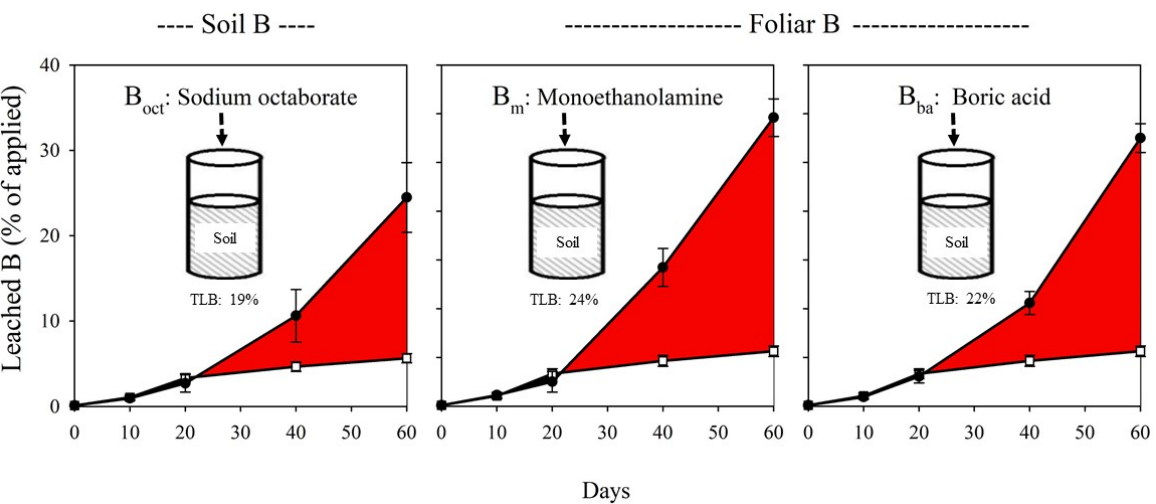
Figure 7. Leached B (% of applied) and total leached B (TLB; %) of sodium octaborate, monoethanolamine, and boric acid. Averages presented with error variation.